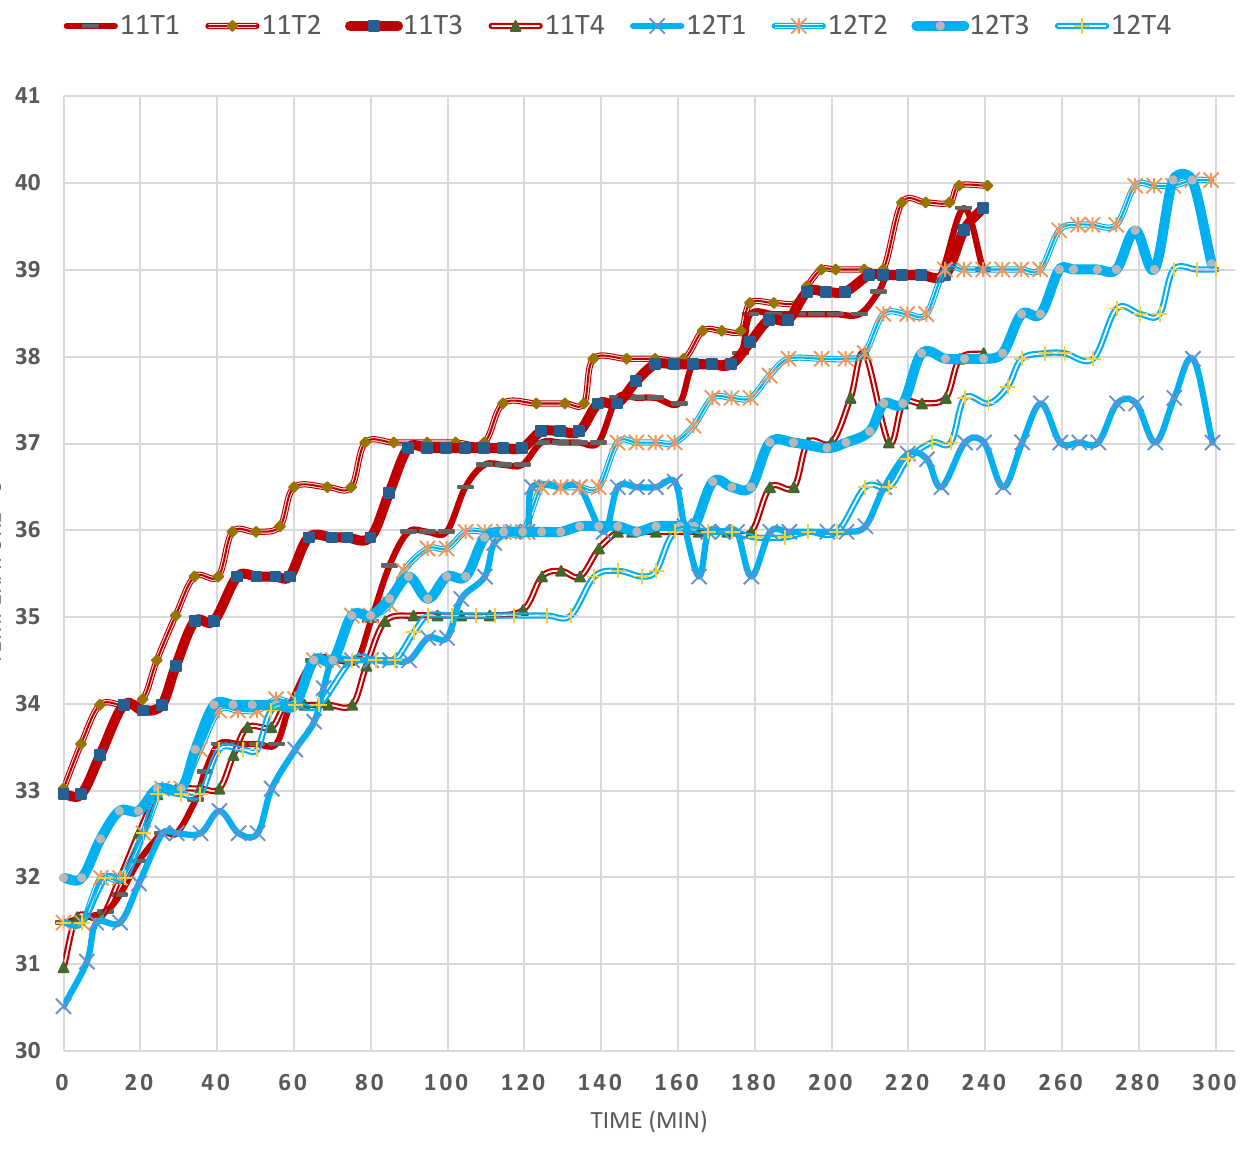
Figure 8. Effect of gel thickening material on the temperature profiles in the SP (EXPs 11 and 12).